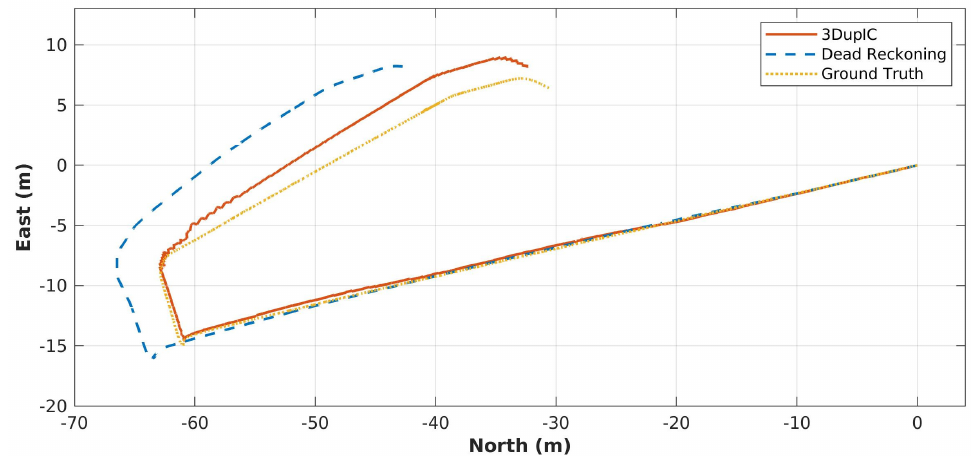
Figure 7. 2D representation of the trajectories obtained from dead reckoning (dashed line), from aid- ing dead reckoning with the 3DupIC corrections (solid line) and the ground truth trajectory (dotted line).